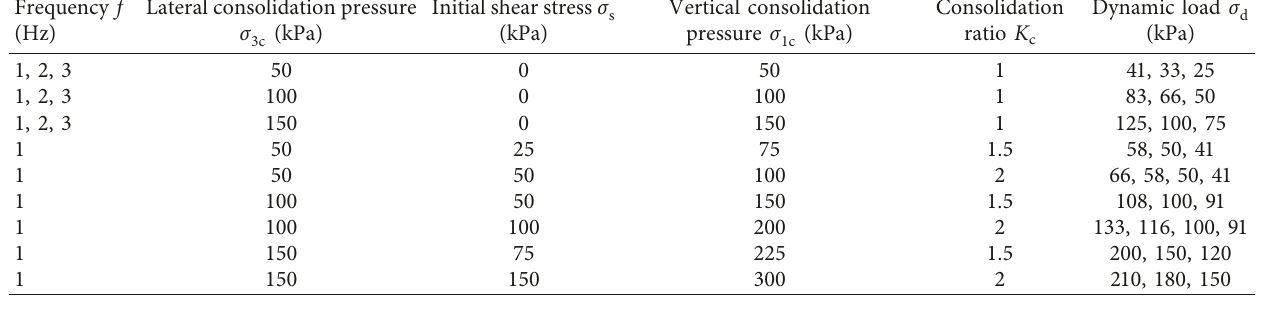
Table 2: Saturated sand dynamic strength test